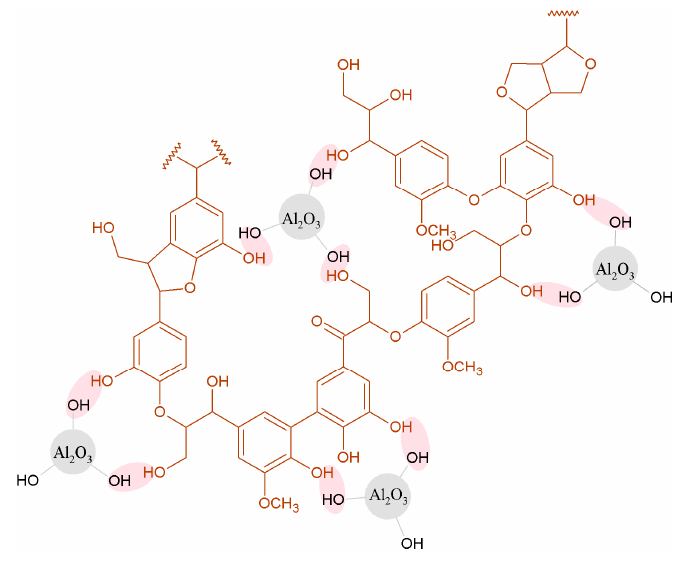
Figure 6. Hypothetical interactions between lignin and alumina.